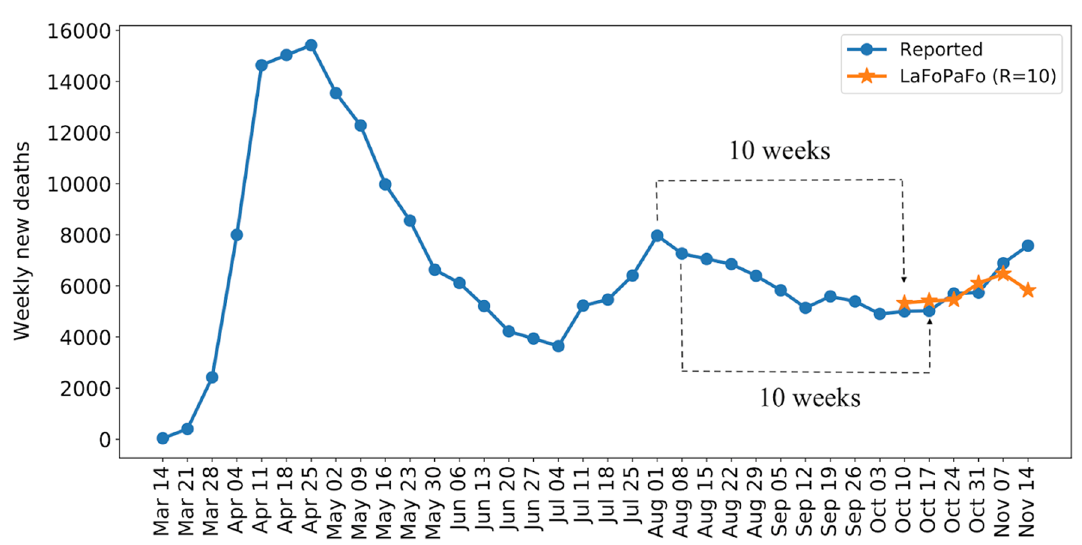
Figure 4. LaFoPaFo’s weekly forecasting results for the number of deaths, ten weeks later, in the US. Note the figure shows only two of the six “10 weeks”